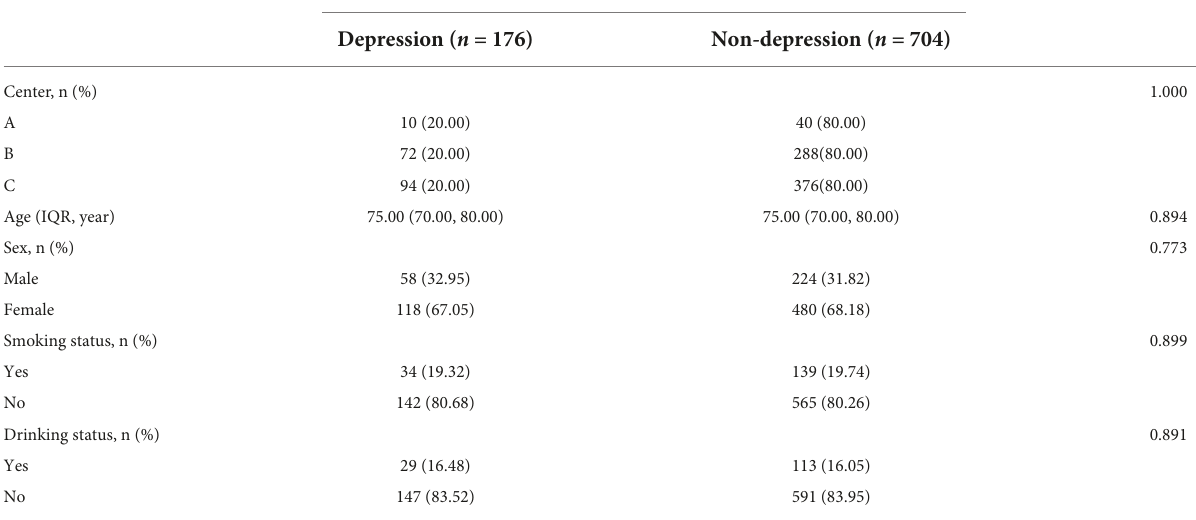
TABLE 1 The baseline data with propensity-score matching analysis in the training set.